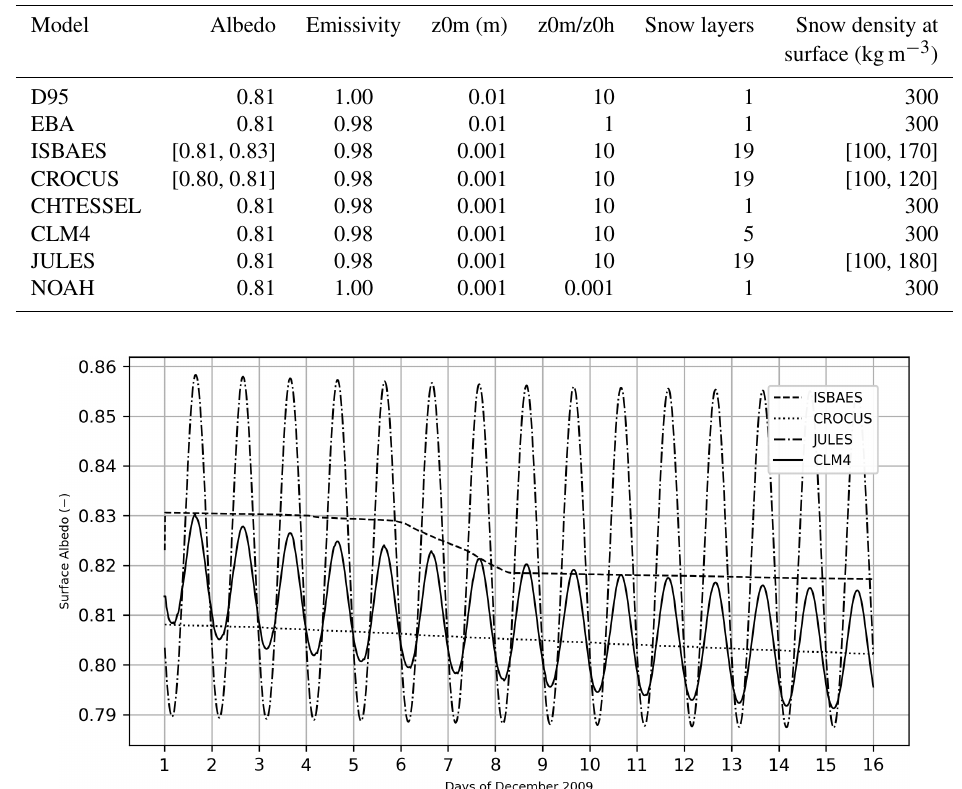
ature PDF is indicated by the black dots, fitted by a cubic function (dashed